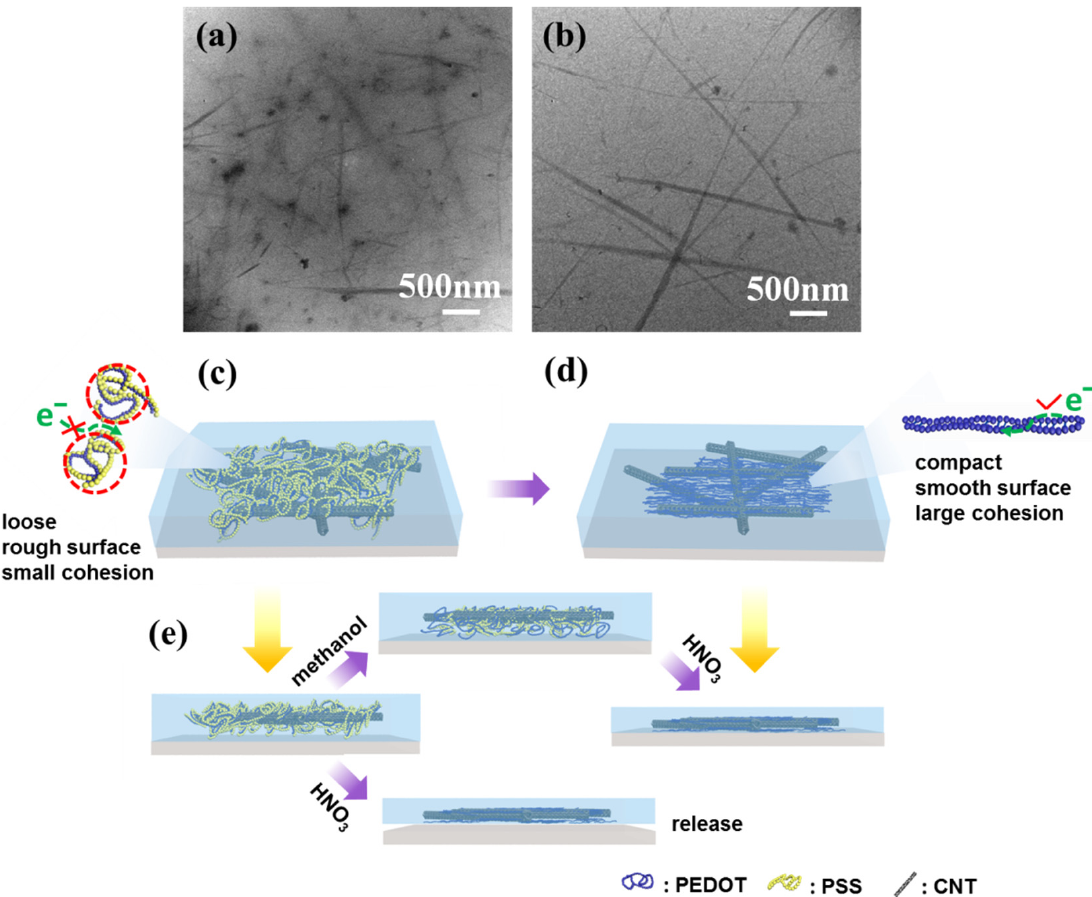
Figure 5. TEM images of ( a ) CNT/P-TCFs and ( b ) CNT/P-NTCFs. The CNT/P-TCFs were prepared at the spin speed of 1000 rpm and CNT solution of 0.2 mg/mL. Corresponding proposed schematic diagrams for the structure of ( c ) CNT/P-TCFs and ( d ) CNT/P-NTCFs. Red lines show spherical PEDOT: PSS chain. ( e ) Schematic of adhesion under different post- treatments.